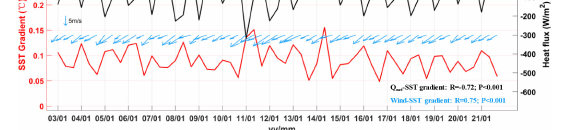
FIGURE 10 Comparison of the SST gradient magnitude (red line), surface net heat fl ux (black line, positive downwards) and wind stress vectors (blue arrows), all three are area-average results of the focus region. The correlation coef fi cients for the regression are